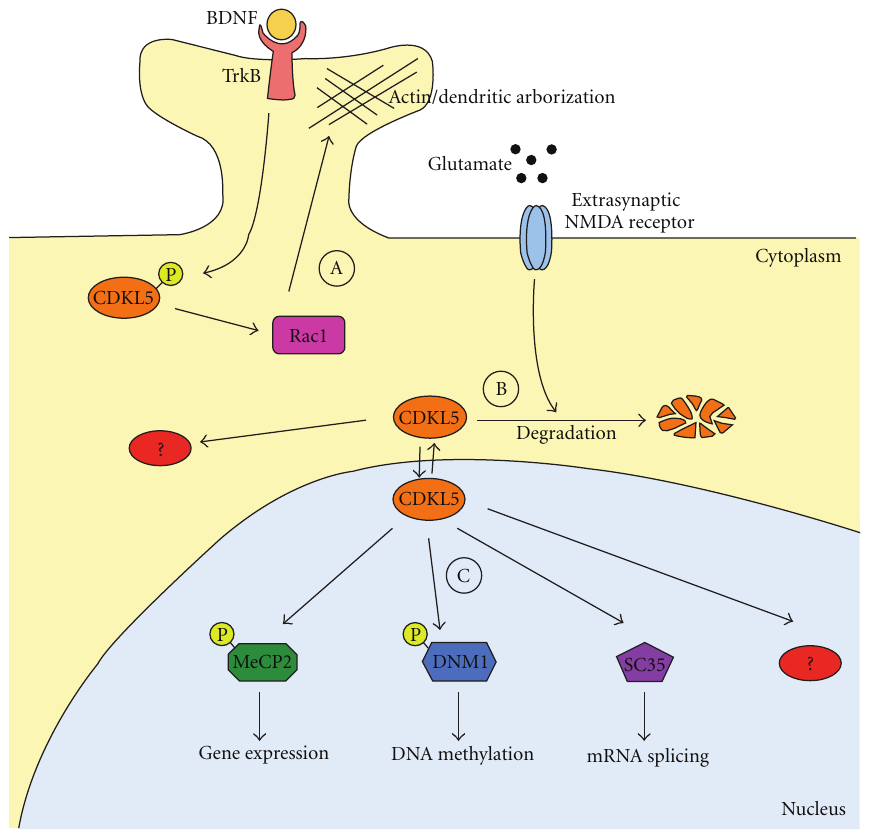
Figure 4: A model depicting the di ff erent functions of CDKL5 in the cytoplasmic and nuclear compartments. As described in the text, CDKL5 functions are occurring both in the cytoplasm and in the nucleus. A. In the cytoplasm, CDKL5 is involved in the regulation of actin cytoskeleton and dendritic arborization. This function is mediated by the interaction of CDKL5 with Rac1. Importantly, a link between BDNF, CDKL5 phosphorylation, and Rac1 activation has been suggested by Chen et al. [24]. B. In the cytoplasmic compartment, the levels of CDKL5 are regulated by degradation. Furthermore, we assume that several phosphorylation targets of CDKL5 remain to be identified. C. In the nucleus, CDKL5 has been proposed capable of interacting with and phosphorylating MeCP2 and DNMT1, thereby influencing gene expression and DNA methylation. Furthermore, the protein has been shown to colocalize with RNA speckles involved in RNA splicing. As for the cytosol, we assume that several other targets of CDKL5 remain to be discovered. In this model, we have neglected the capability of the nuclear CDKL5 to influence dendritic arborization [24] and the transcriptional regulation of CDKL5